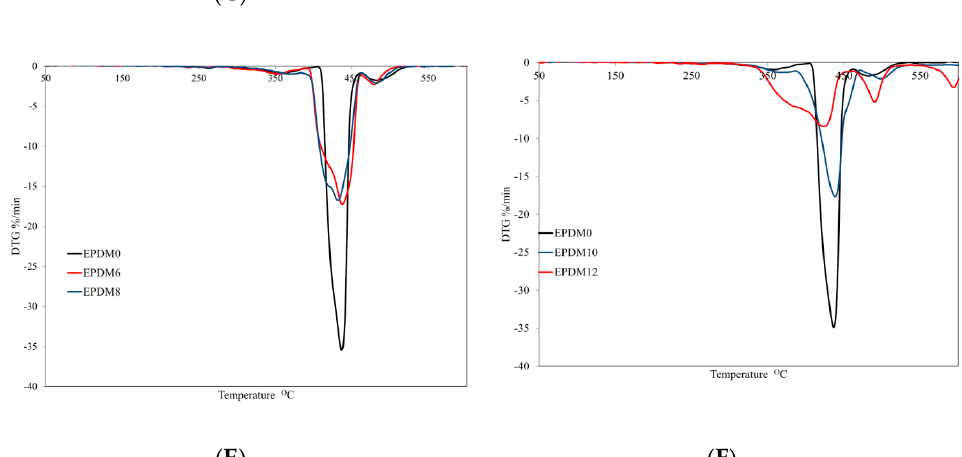
Table 2. Thermal parameters of the EPDM rubber composites.